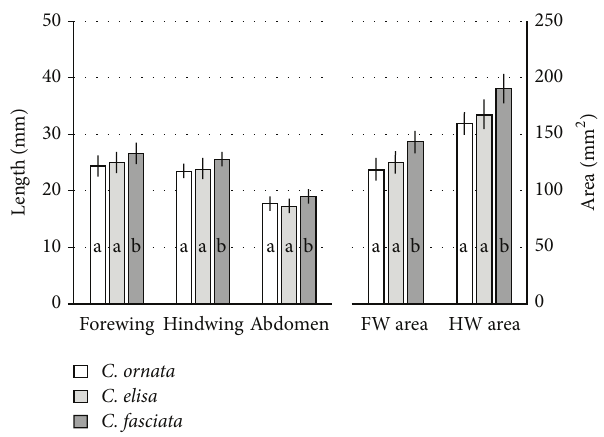
Figure 1: Mean comparisons of five body size indicators between males of Celithemis ornata ( 𝑁 = 51 ), C. elisa ( 𝑁 = 139 ), and C. fasciata ( 𝑁 = 31 ) collected at Ashmore Heritage Preserve, Greenville County, SC, USA, from May to July 2015. Mean ( ± SD) lengths of forewing, hindwing, and the abdomen and the area of forewing (FW area) and hindwing (HW area) were compared. For each attribute, species labeled with the same letter are not significantly different (Tukey mean comparison tests, 𝑃 = 0.05 ).